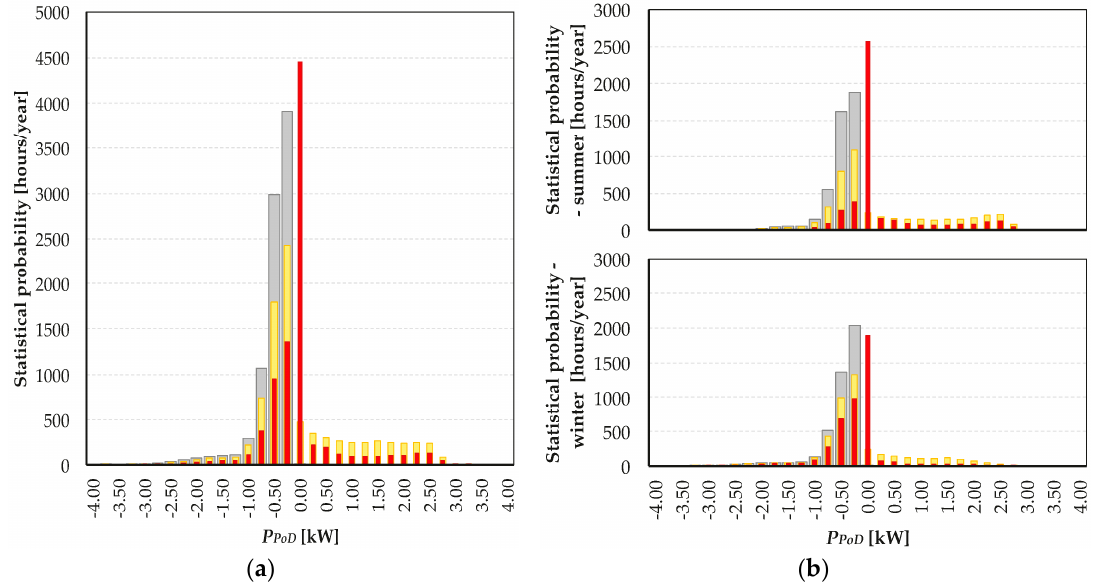
Figure 6. Statistical distribution of the power flow P PoD exchanged between the final customer and the network, for the three analyzed scenarios ( P PoD > 0 means power injection into the grid). With a BESS, P PoD is frequently close to zero, thus limiting the end-user impact on network management issues, (e.g., voltage regulation and distribution losses). ( a ) Yearly statistical distribution; ( b ) Spring-summer statistical distribution (upper image), and fall-winter statistical distribution (lower image).